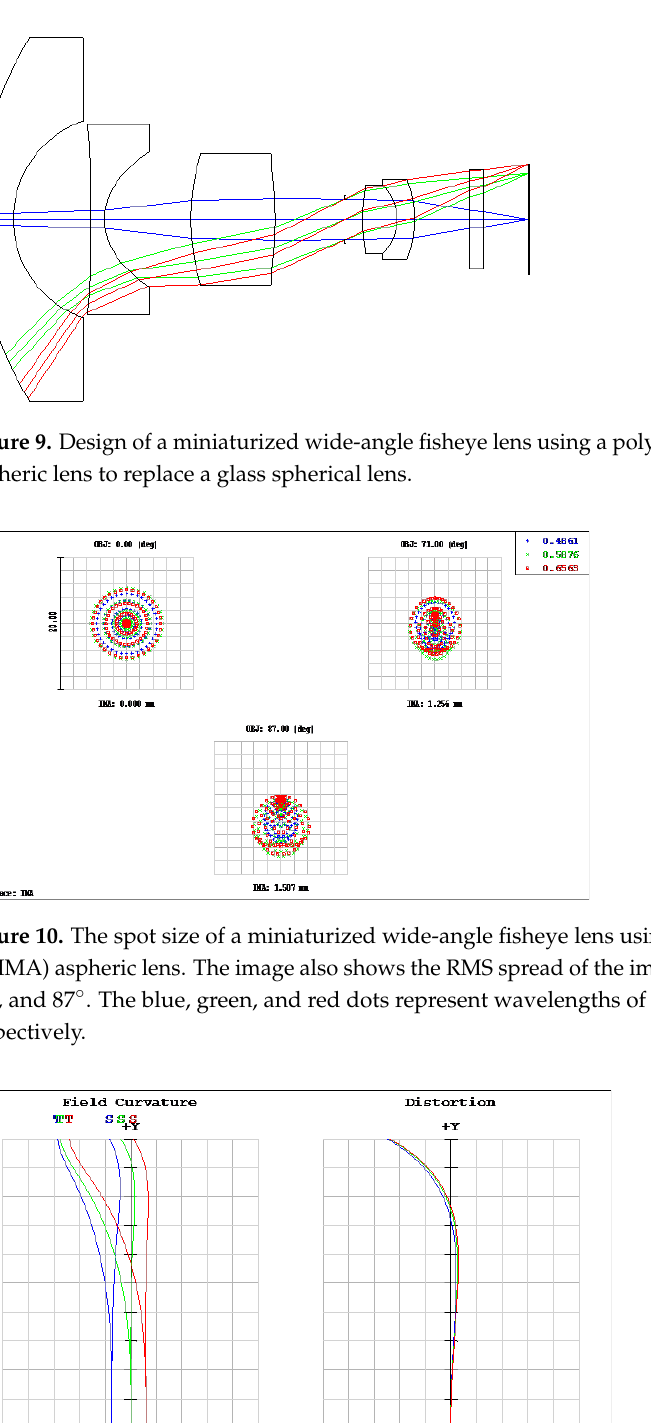
of a fisheye lens using an OKP4HT aspherical lens design, in terms of RMS spot radius, field curvature, distortion, and MTF values.